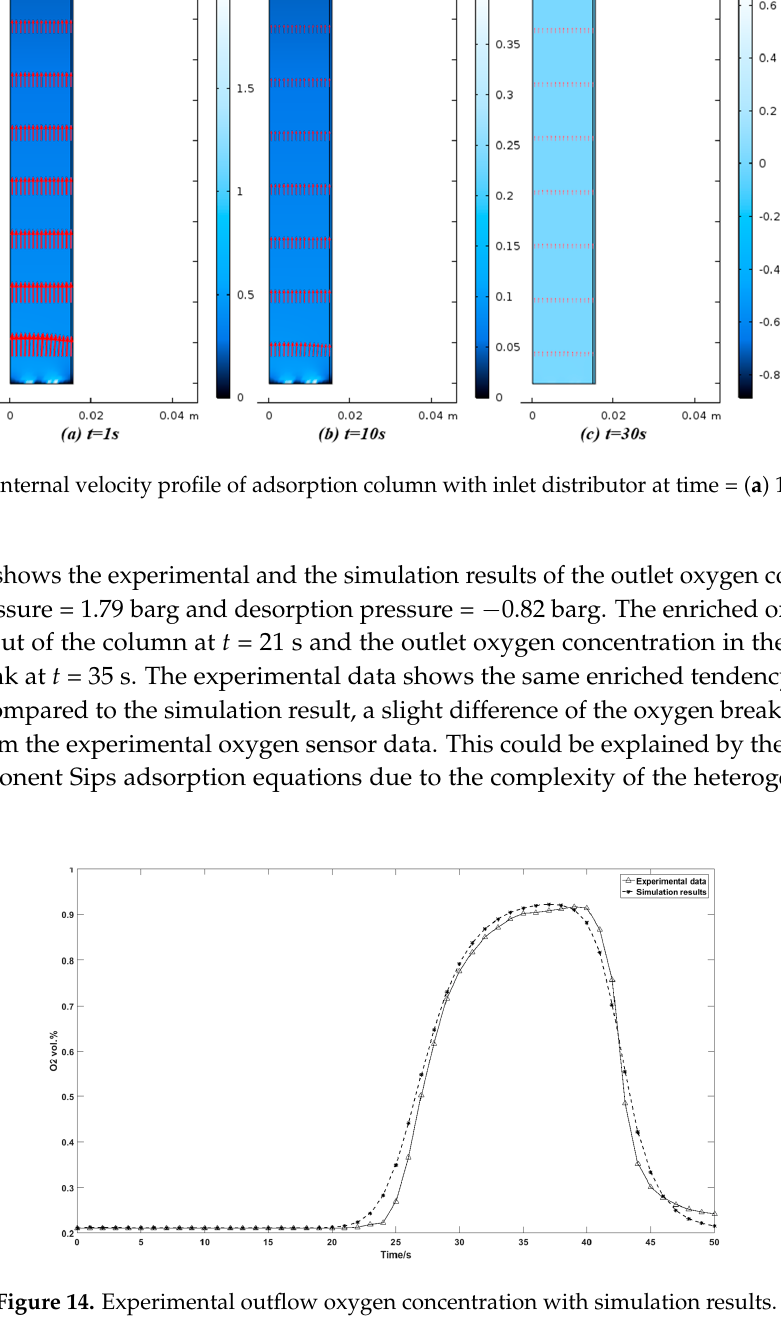
Figure 12. Comparison of the experimental and simulation results of the column outlet pressure.